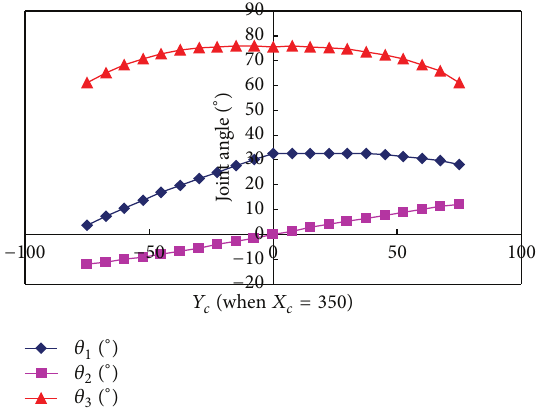
Figure 13: Key sample points chosen for verifying the fitted cam model.